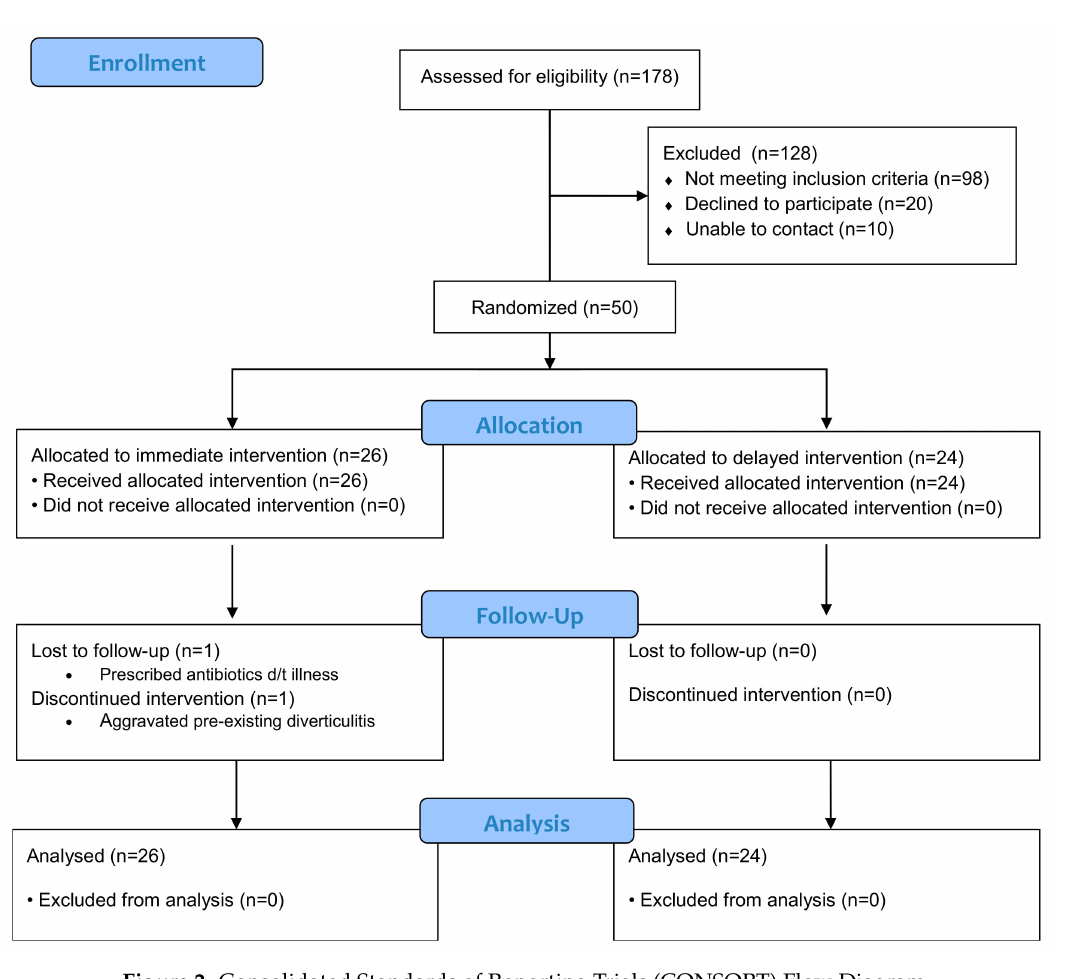
Figure 2. Consolidated Standards of Reporting Trials (CONSORT) Flow